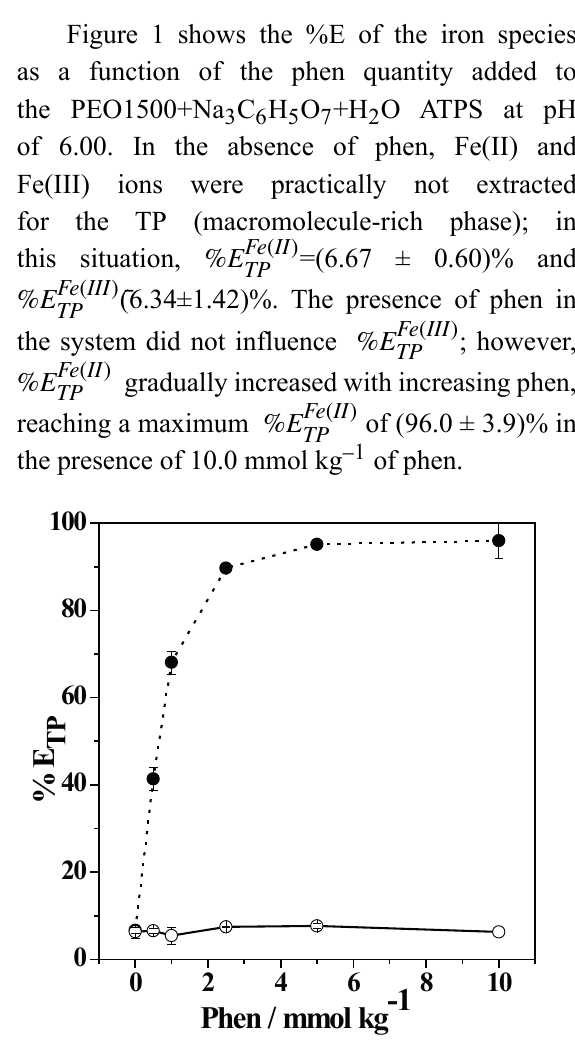
Figure 1 - Effect of 1,10-phenatroline (phen) quantity added to PEO1500 + Na 3 C 6 H 5 O 7 +H 2 O ATPS on the %E TP of iron species: ( • ) Fe(II); ( ◦ ) Fe(III); [iron] = 0.100 mmol kg -1 ; pH=6.00; T=25.0 °C;